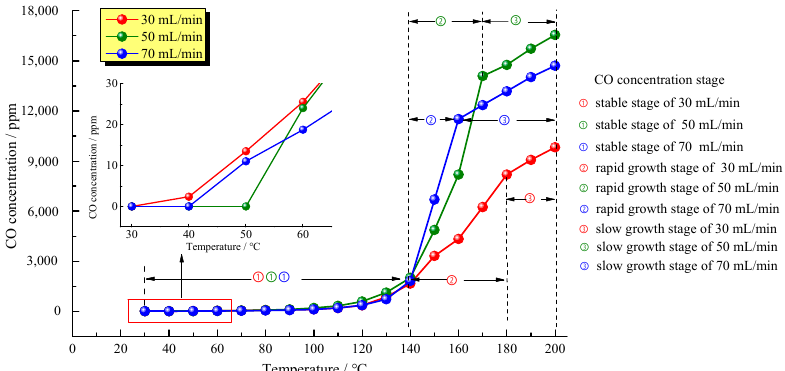
Figure 3. Relationship between the CO concentration and the temperature at different air supply rates.